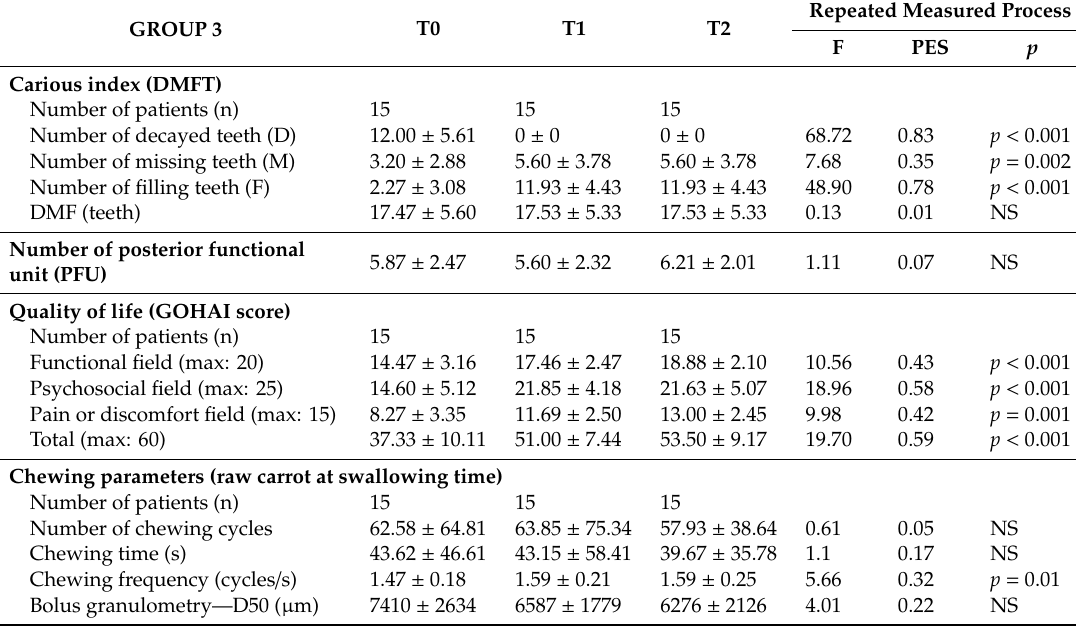
Table 5. Comparison of study criteria describing patients in Group 3 at di ff erent times of evaluation (repeated measures ANOVA with post hoc Bonferroni